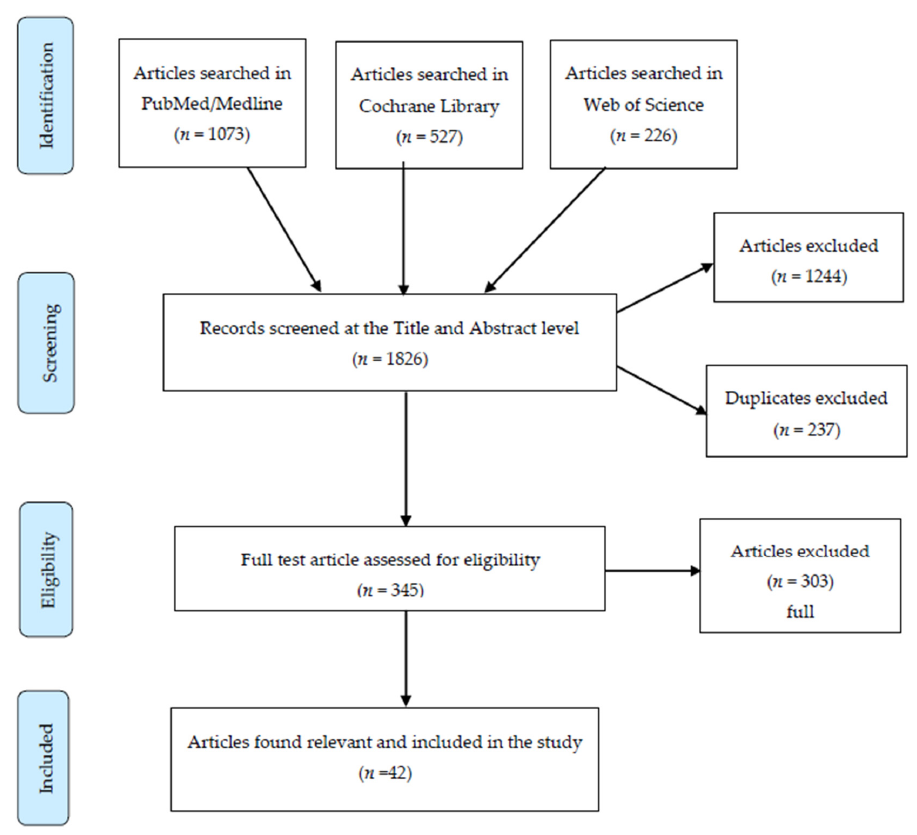
Figure 2. Review flow chart. The figure shows the progress of the literature review process following the PRISMA 2009